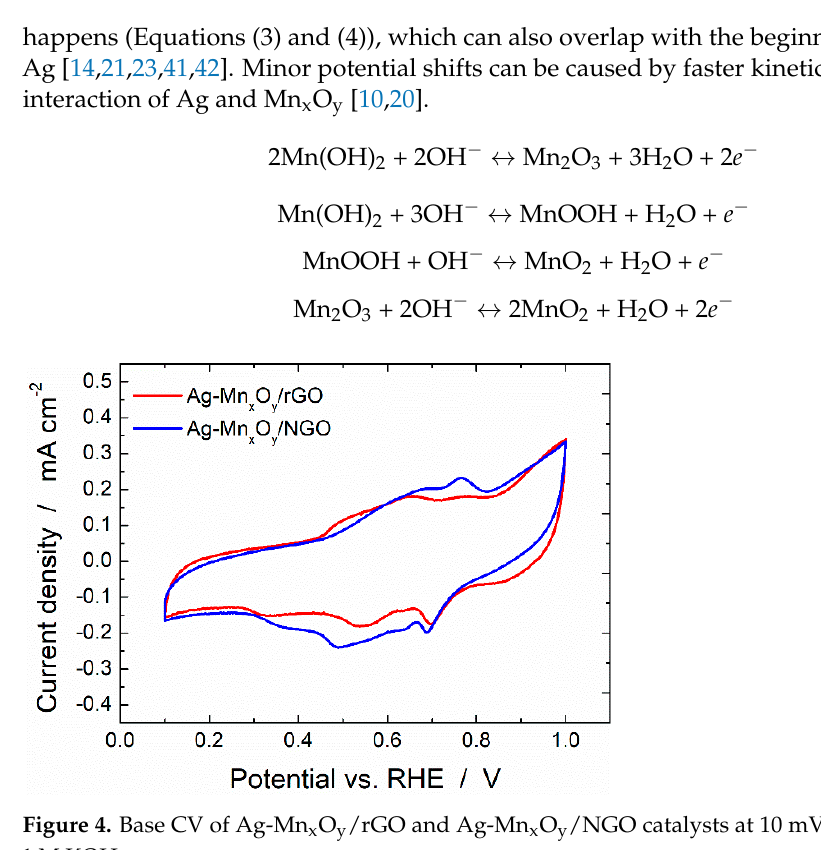
Table 3. Electrochemical characterization results of the graphene derivatives, Ag-Mn x O y /C composites, and Pt/C catalyst. Catalysts